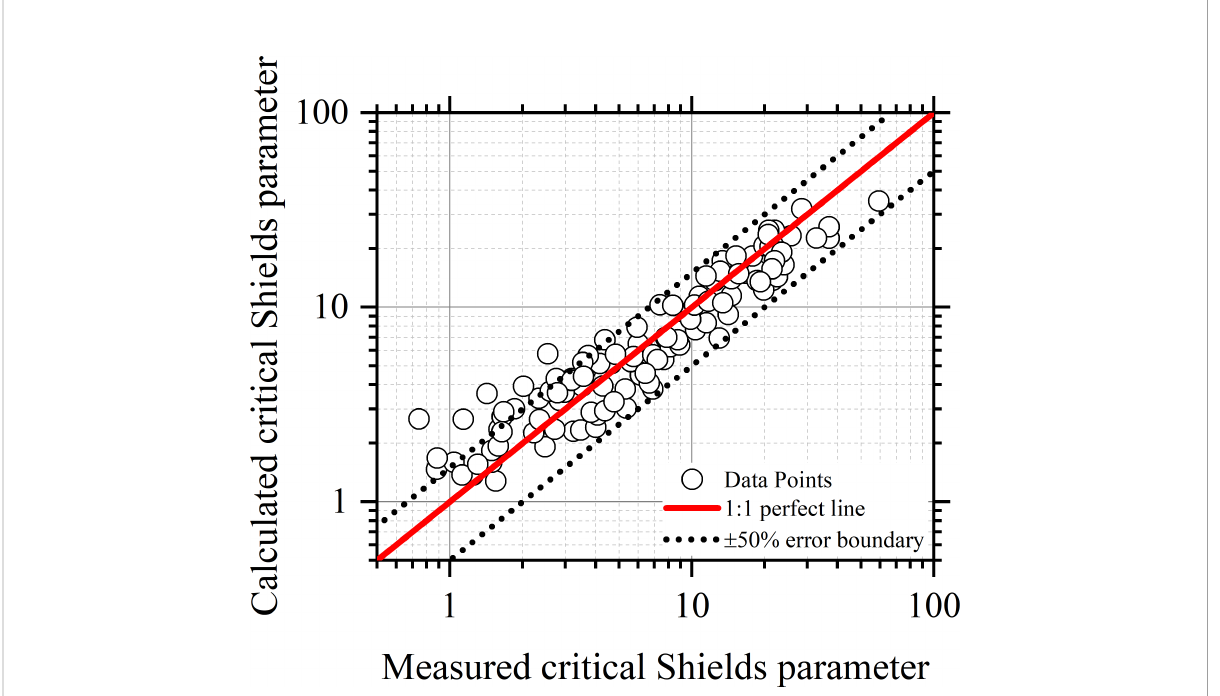
FIGURE 10 Comparison of the calculated critical Shields parameters by Eq. (30) and measured critical Shields parameters for sediments of the contribution rate of effective gravity lower than 30% in the datasets of coastal